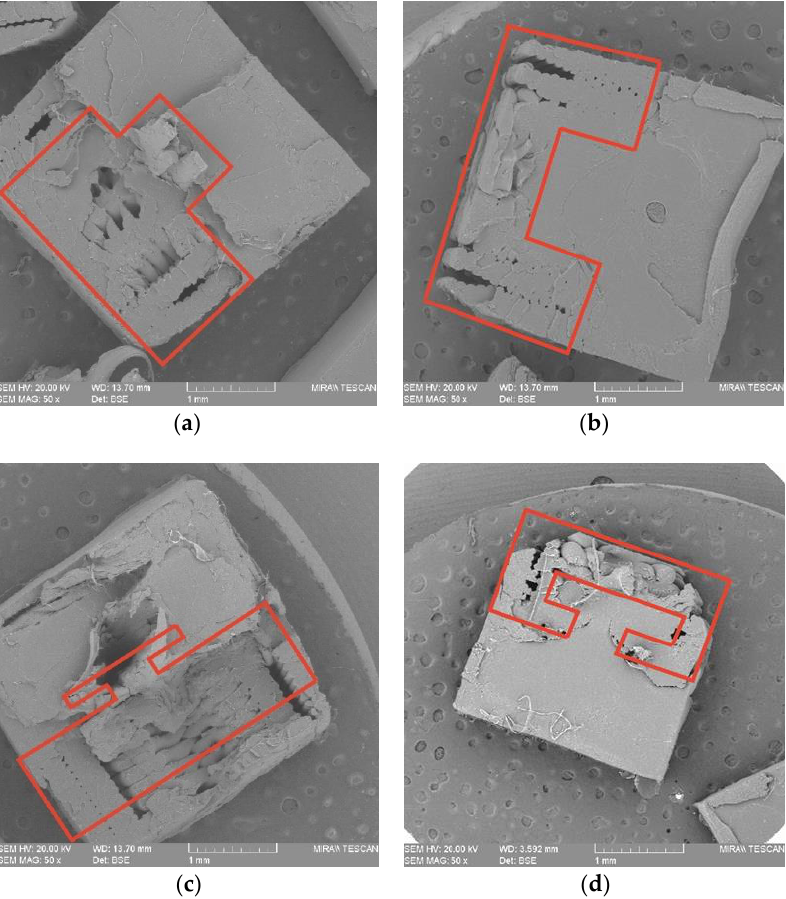
Figure 10. SEM observations on the fractured surfaces of ( a ) MC 75; ( b ) FC 75; ( c ) MT 75 and ( d ) FT 75, in which the FDM preforms have been indicated in red.